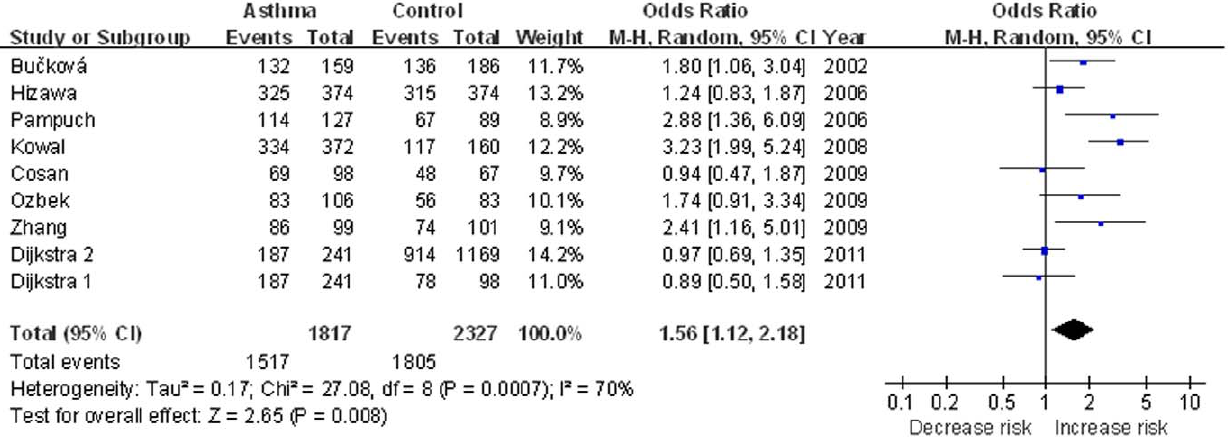
Figure 2. Meta-analysis with a random-effects model for the association between asthma risk and the PAI-1 4G/5G polymorphism (4G4G + 4G5G vs. 5G5G).